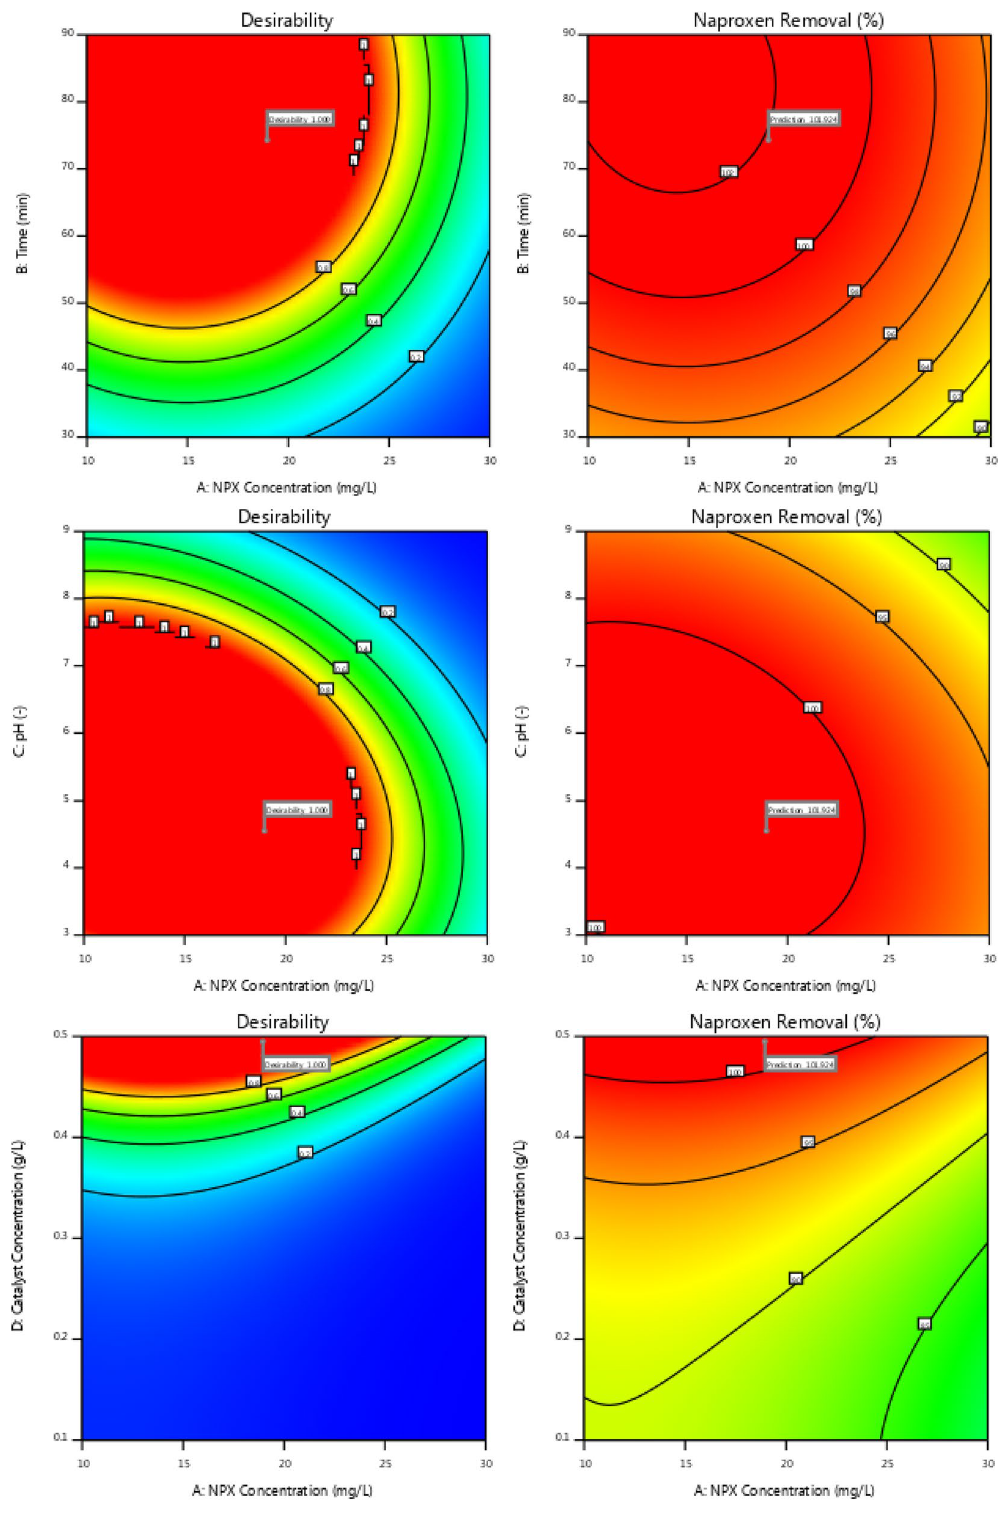
Figure 12. A range of independent variables of pH, photocatalyst dosage, time, and initial naproxen